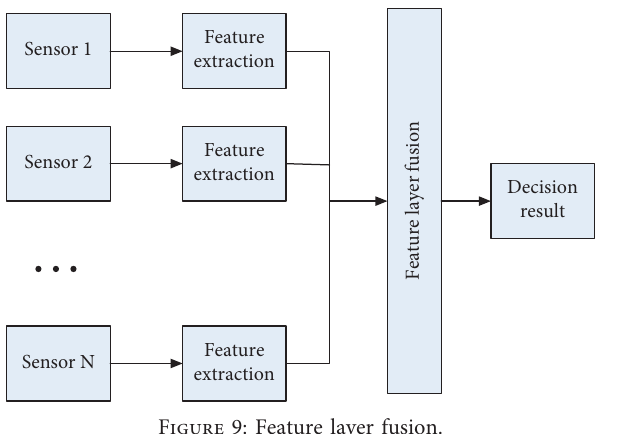
Figure 9: Feature layer